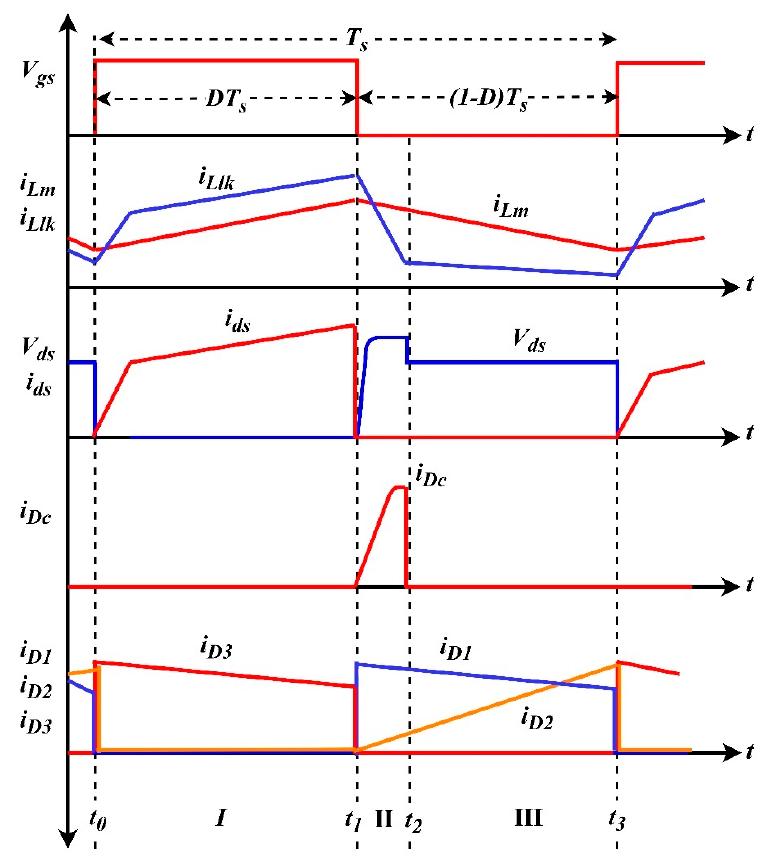
Figure 2. Theoretical waveform of the proposed converter during CCM.